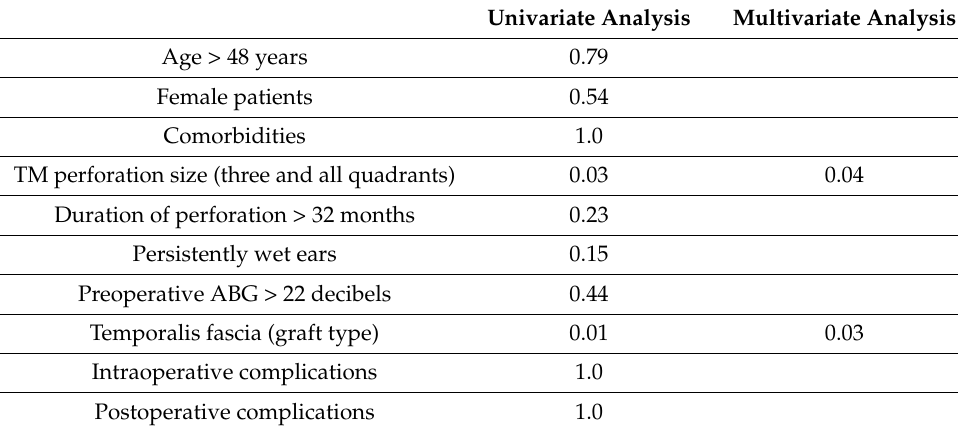
Table 3. Univariate and multivariate analysis of outcome (i.e., postoperative TM perforation) in chronic otitis media patients showing excessive bleeding during